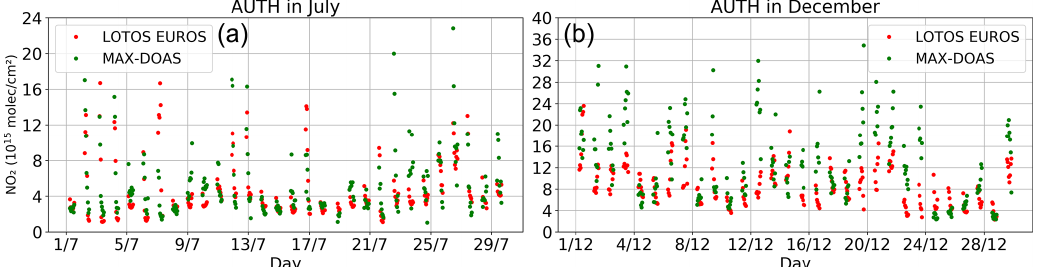
Figure 6. Time series of LOTOS-EUROS (red) and MAX-DOAS (green) NO 2 columns over AUTH for July (a) and December (b) 2018. Table 3. Statistics between the MAX-DOAS observations and the LOTOS-EUROS simulations for July and December in Thessaloniki. MAX-DOAS mean and SD LOTOS-EUROS mean and SD Absolute bias Relative